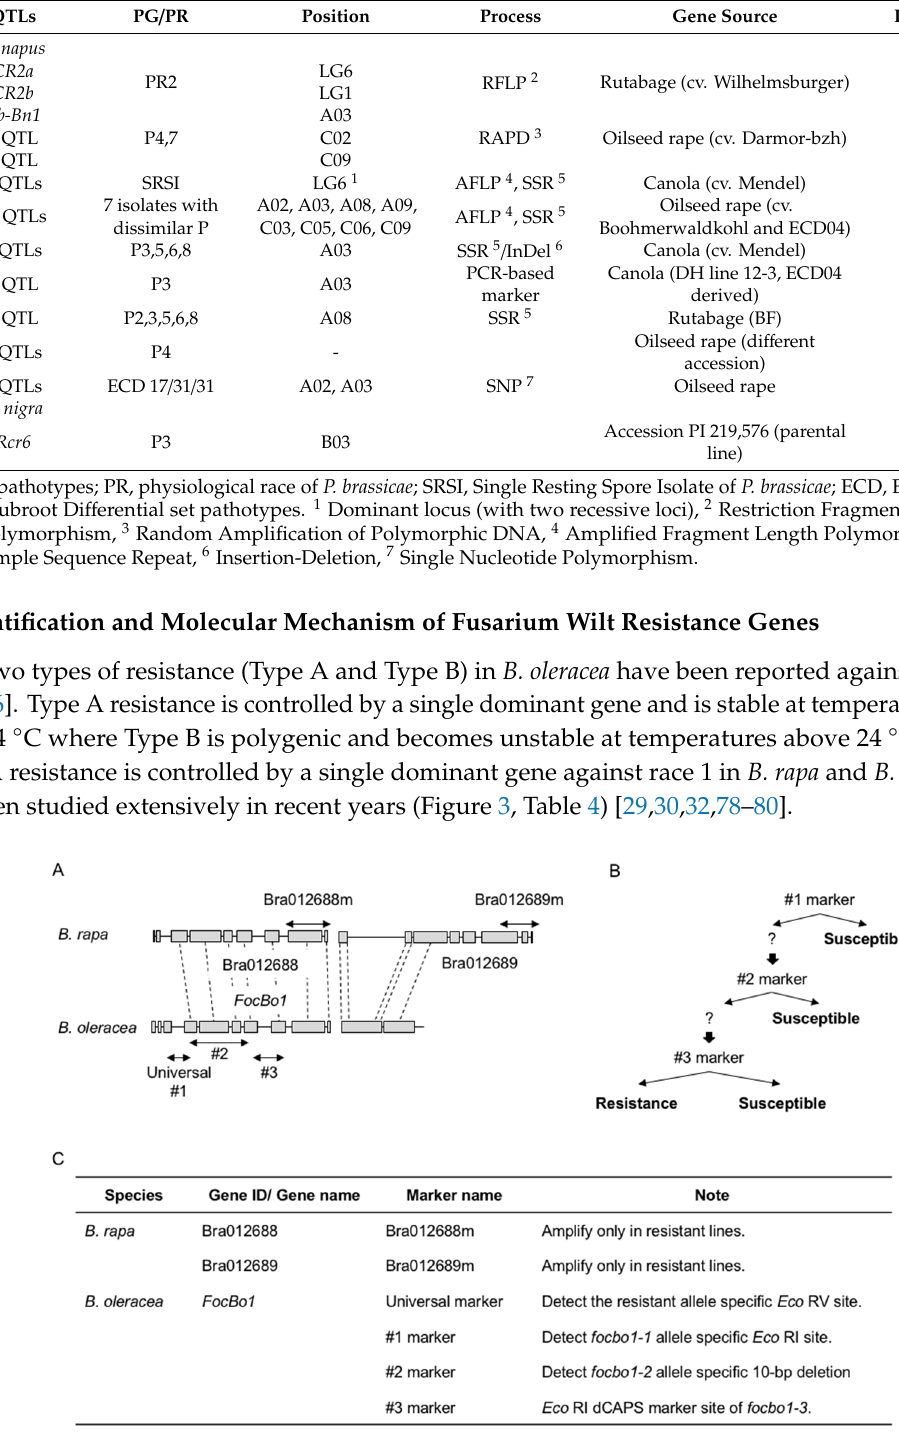
Figure 3. Schematic view of the alignment of resistance genes of Fusarium wilt disease. ( A ). DNA marker positions of resistance genes in B. rapa and B. oleracea . Arrows indicate marker positions. ( B ). Scheme of marker assisted selection in B. oleracea . ( C ). DNA marker list for marker assisted selection in B. rapa and B. oleracea . Table 4. Loci of resistance gene to Foc reported in Brassica species.